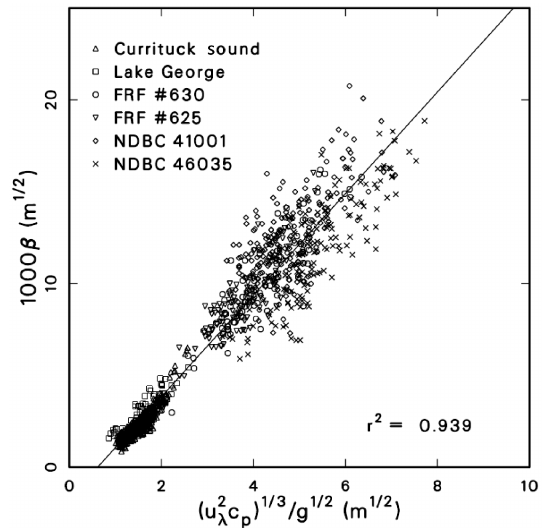
Figure 1. Correlation of the equilibrium range coefficient β with (u 2 c p ) 1 / 3 /g 1 / 2 based on data from six disparate sources. Adapted λ from Resio et al.